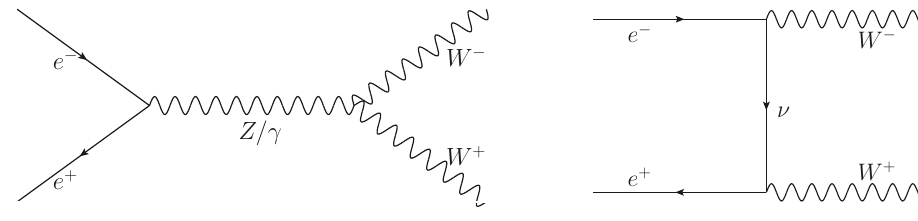
Figure 5 . Leading-order diagrams contributing to e + e left with an intermediate Z or photon involves a triple gauge